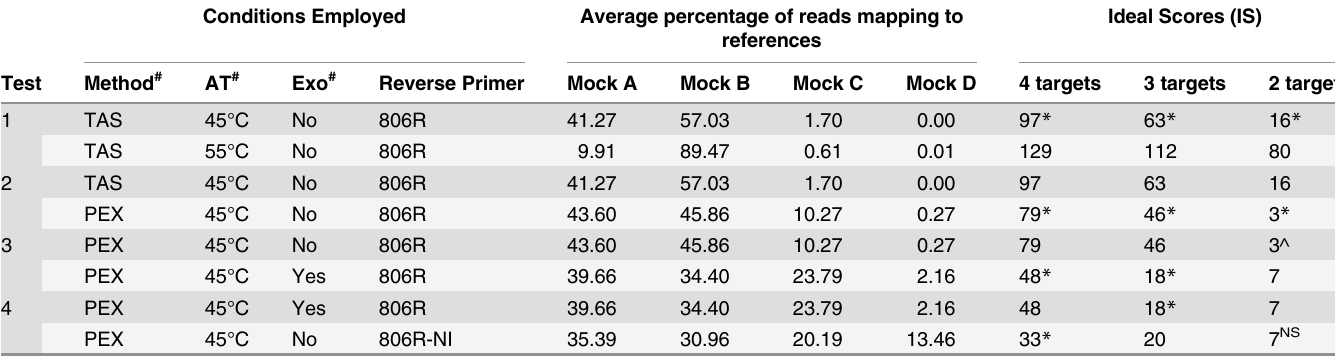
Table 2. Amplification and sequence analyses of mock community